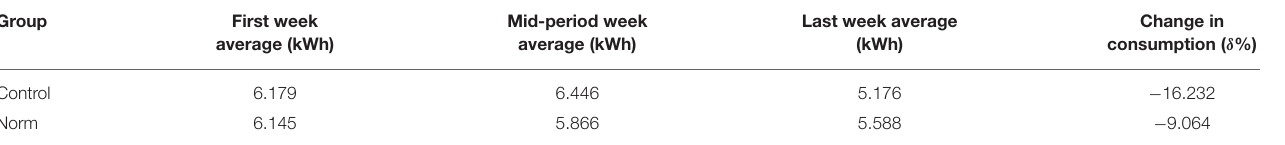
TABLE 3 | Daily average hourly electricity use for households by groups.